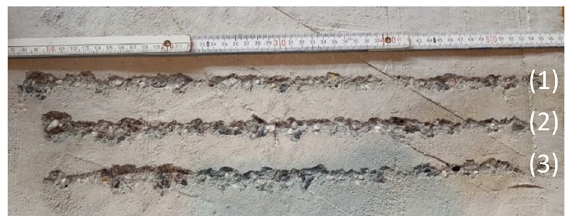
Fig. 10 Traces of concrete removal for a speed of 1.6 m/min and an impulse frequency of (1) 5 Hz, (2) 10 Hz and (3) 15 Hz